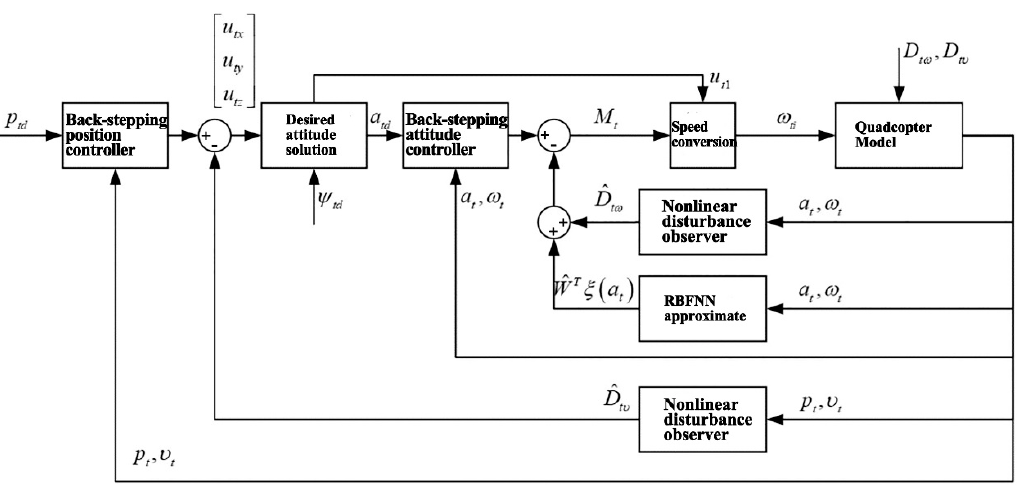
Figure 21. Structural diagram of quadcopter trajectory tracking controller.